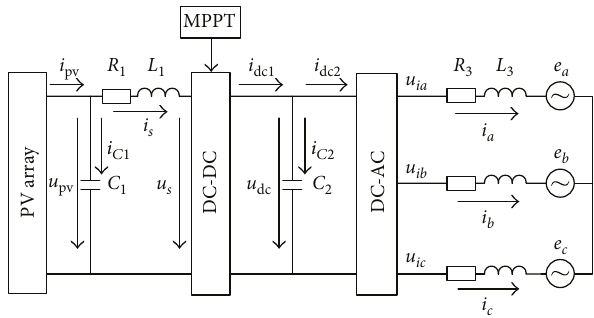
Figure 1: Main circuit of a grid-connected PV system.